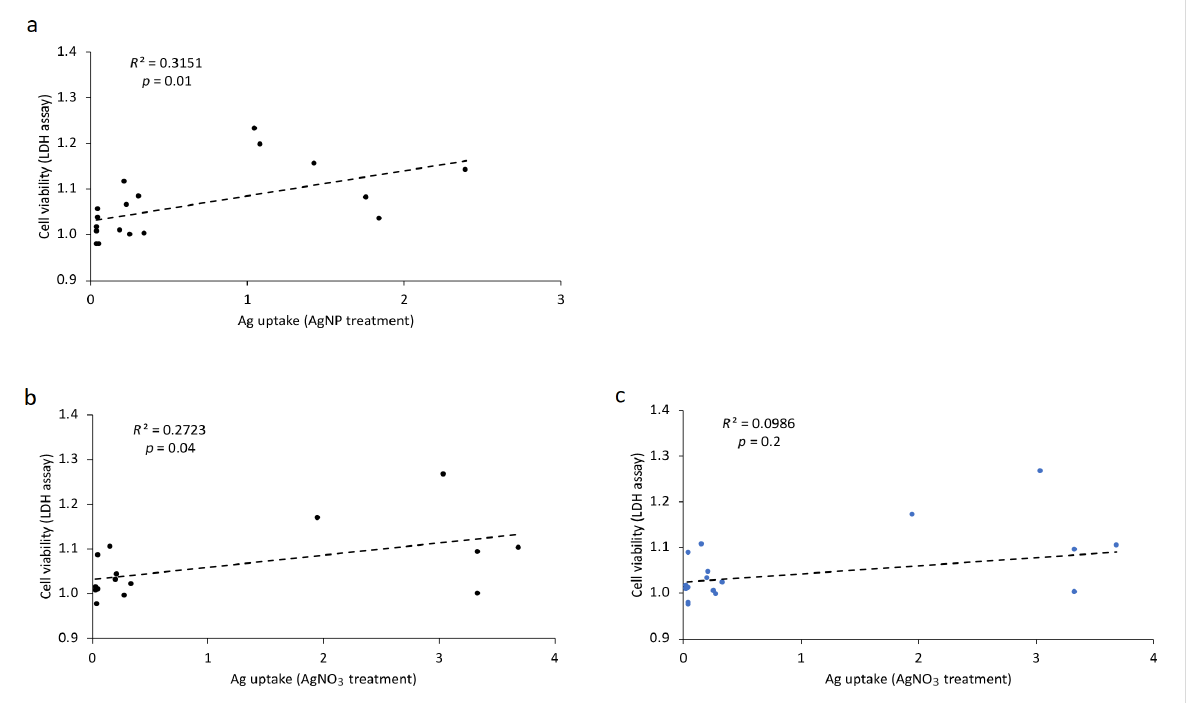
Figure 6: Pearson correlation between uptake and cytotoxicity (LDH assay) of Ag. Correlation between uptake and toxicity of Ag after treatment with AgNPs (a) and AgNO 3 (b, c). There was a moderate positive correlation between the two variables (uptake and toxicity) for AgNPs: r = 0.56, p = 0.01 (a) and AgNO 3 excluding Person 5: r = 0.52, p = 0.04 (b). No correlation was detected in AgNO 3 including Person 5: r = 0.314, p = 0.2 (c).